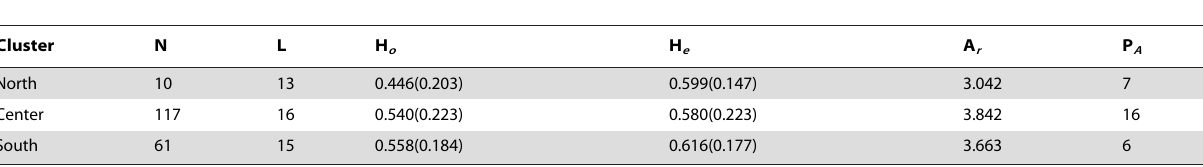
Table 2. Summary statistics for the clusters identified in the individual assignment test (STRUCTURE).